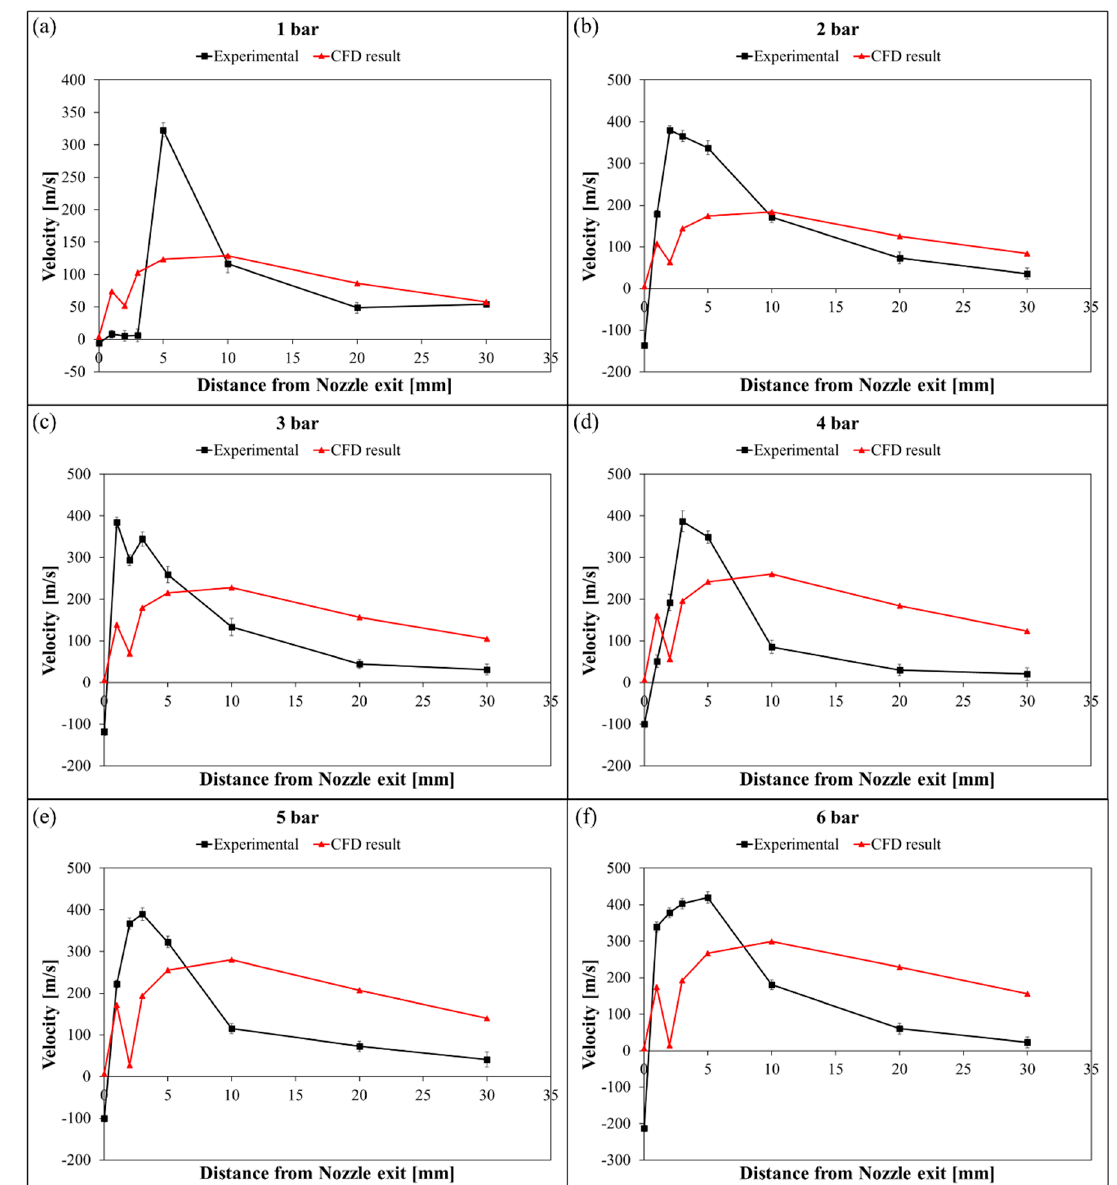
Figure 5. Comparison between CFD and experimental results for output air velocity at different input pressure values: ( a ) 1 bar, ( b ) 2 bar, ( c ) 3 bar, ( d ) 4 bar, ( e ) 5 bar, and ( f ) 6 bar.